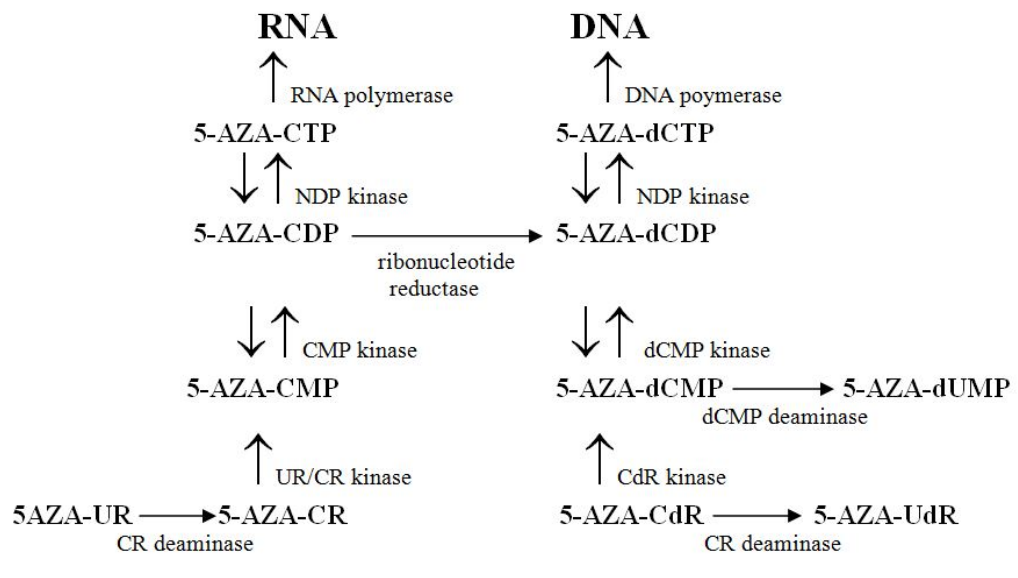
Figure 1. Metabolism of 5-aza-2 ′ -deoxycytidine (5-AZA-CdR) and 5-azacytidine (5-AZA- CR). Both these nucleoside analogues are pro-drugs that have to be activated by phosphorylation. Deoxycytidine kinase activates 5-AZA-CdR, which is converted to its triphosphate form by kinases and incorporated into DNA. Cytidine (CR) deaminase inactivates both 5-AZA-CdR and 5-AZA-CR. dCMP deaminase inactivates 5-AZA-CdR monophosphate (5-AZA-dCMP). 5-AZA-CR is activated by uridine/cytidine (UR/CR) kinase, phosphorylated to its triphosphate and incorporated into RNA. Ribonucleotide reductase converts 10–20% of the diphosphate form of 5-AZA-CR (5-AZA-CDP)) to its deoxyribose form (5-AZA-dCDP), which is phosphorylated to 5-AZA-dCTP and incorporated into